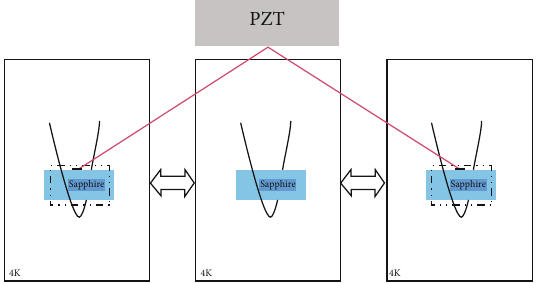
Figure 3: Simpli fi ed model of experiment of periodic tidal gravitational signals. The emitter also can be used as a calibrator for GW detectors. Source - From the authors